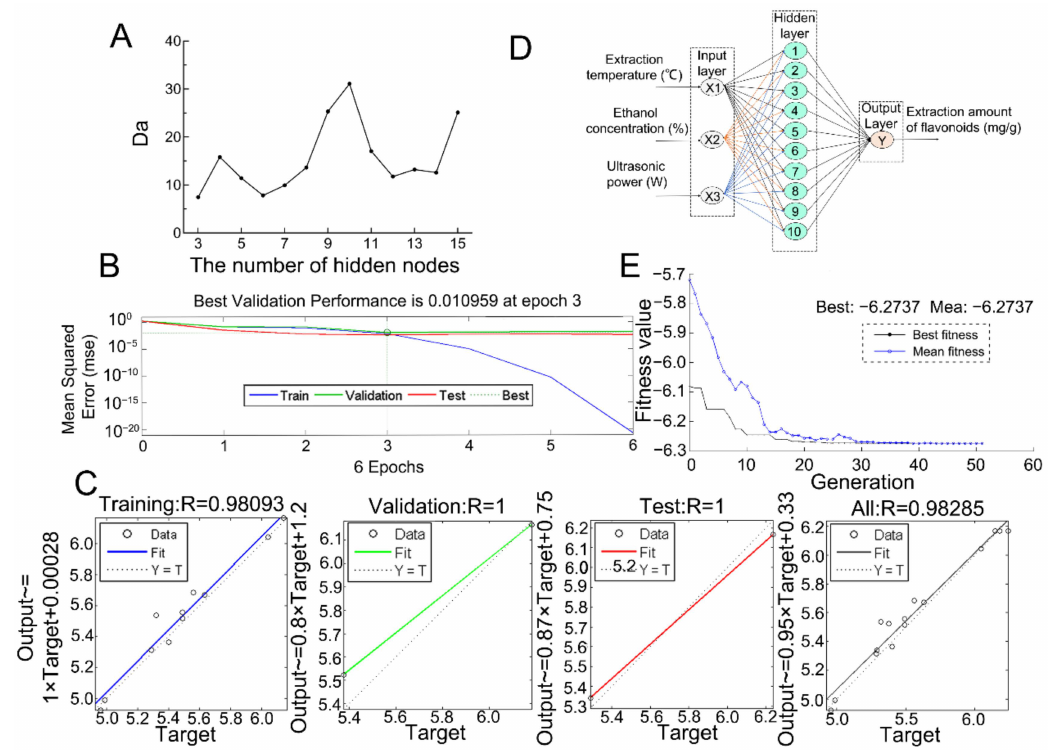
Figure 4. ANN modeling and training. ( A ) The effect of the number of neurons in the hidden layer on the degree of approximation ( Da ). ( B ) Training performance of ANN. ( C ) Regression analysis diagram of actual data and predicted data by ANN (3–10–1) model. ( D ) ANN model architecture topology